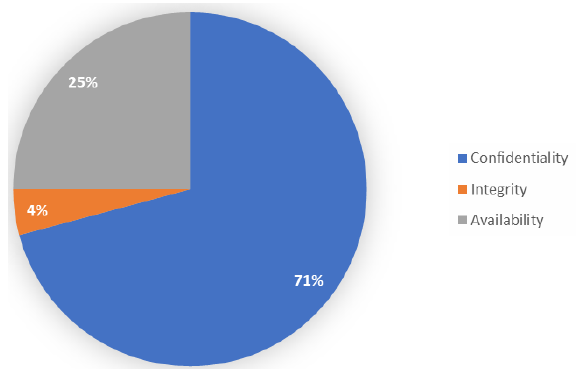
Figure 1. Cyber-Attack Class based on Security